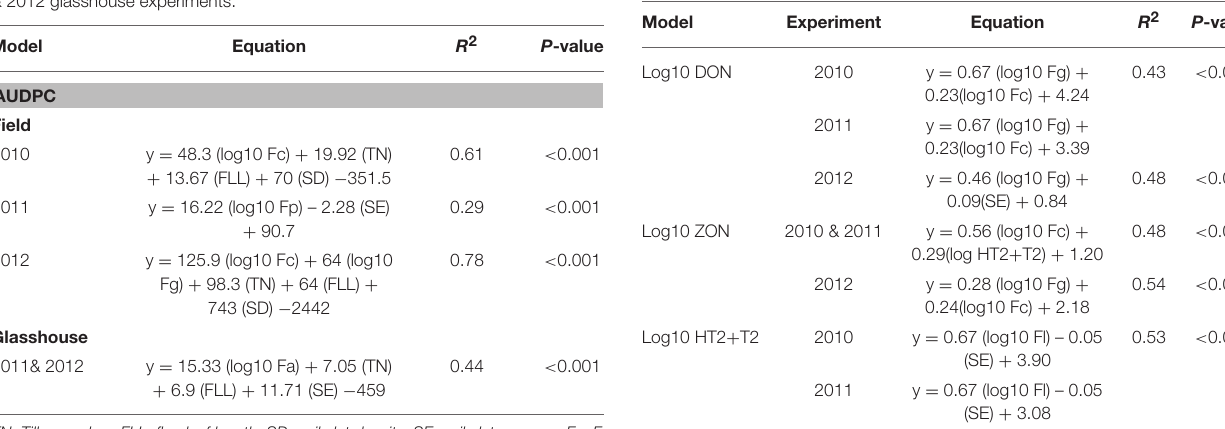
TABLE 7 | Multiple Linear Regression of physiological traits and Fusarium spp. DNA (pg ng − 1 of Total DNA) on mycotoxin concentration in harvested grain in field experiments 2010, 2011, and